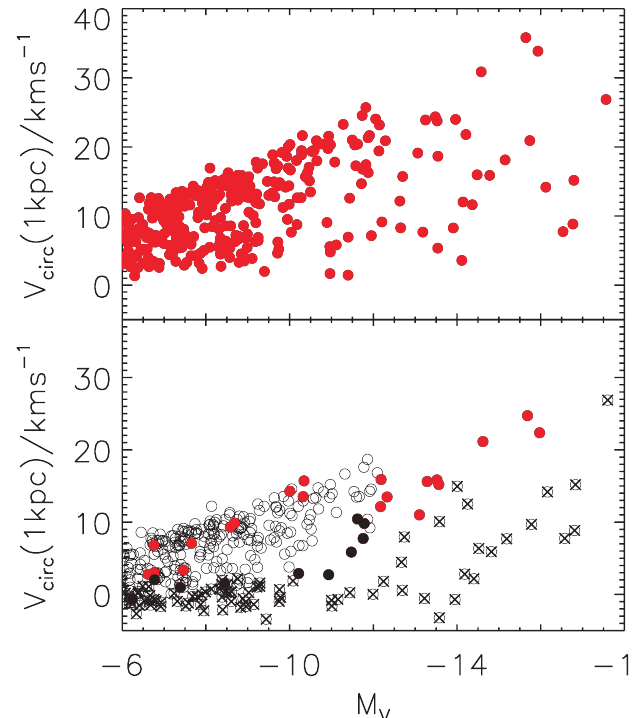
Fig. 2. Plot of v 1kpc vs. M V for the VL2 simulation subhaloes. In the top panel, we plot the VL2 satellites at z = 0, as in B13. In the bottom panel, we represent the same VL2 satellites with the baryonic corrections (see the text) applied. The filled black circles represent satellites that have lost enough mass (stars are stripped and the luminosities are upper limits). Filled red circles are for satellites observed at z = 0, while circles with “x” denote subhaloes that have low probability to survive tidal effects. Dark subhaloes are represented by empty